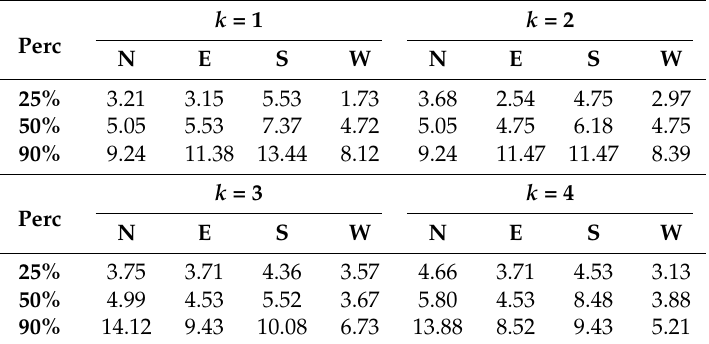
Table 3. Precision of Test